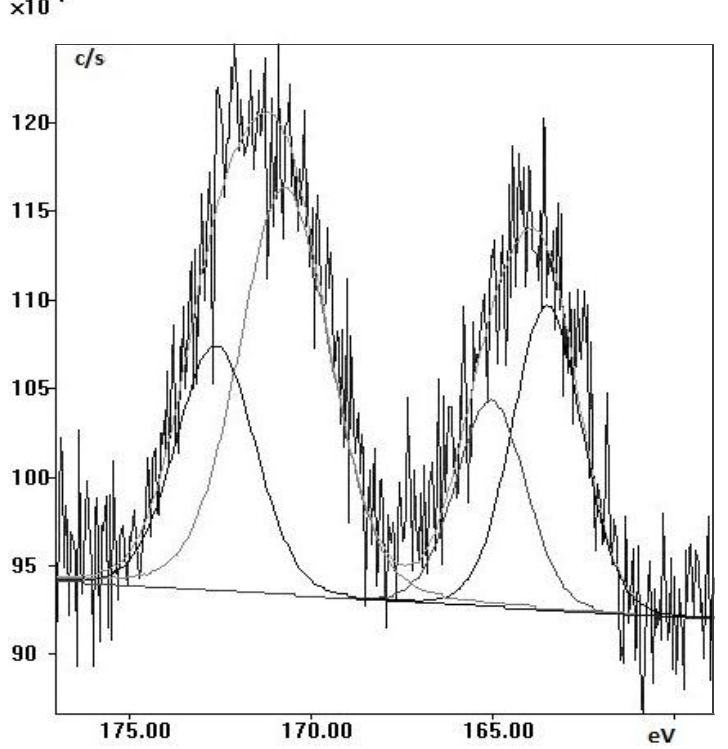
Figure 9. Sample C.3.1.1: XPS region of Sulfur 2p. Two different bands are quite evident due to sulfate atoms (higher binding energy) and to sulfide atoms (lower binding